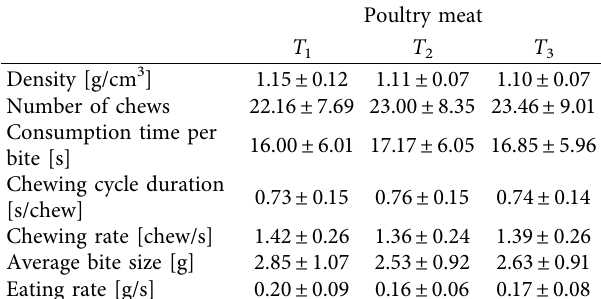
Table 3: Summary of the oral processing behavior parameters for poultry meat samples prepared using three grilling working